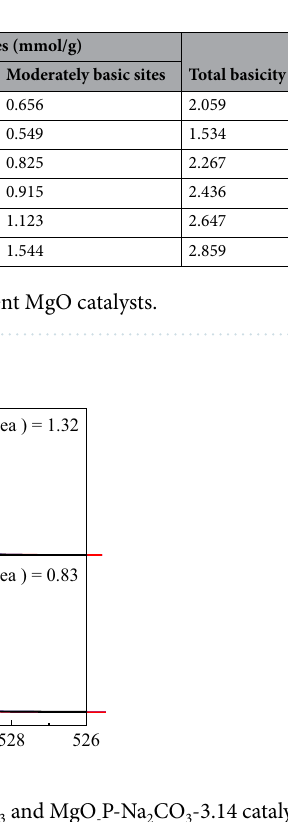
Figure 9. O 1 s XPS spectra of MgO -P-NaOH-3 and MgO - P-Na 2 CO 3 -3.14